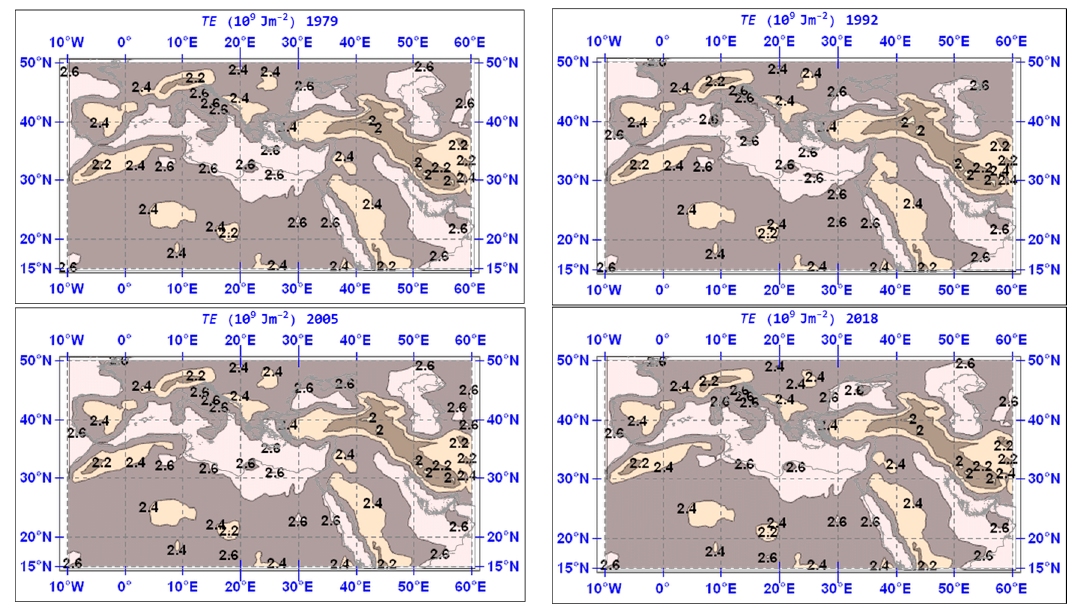
Figure 7. Same as Figure 4 but for TE . Isopleths are drawn for every 0.2 × 10 9 Jm − 2 .